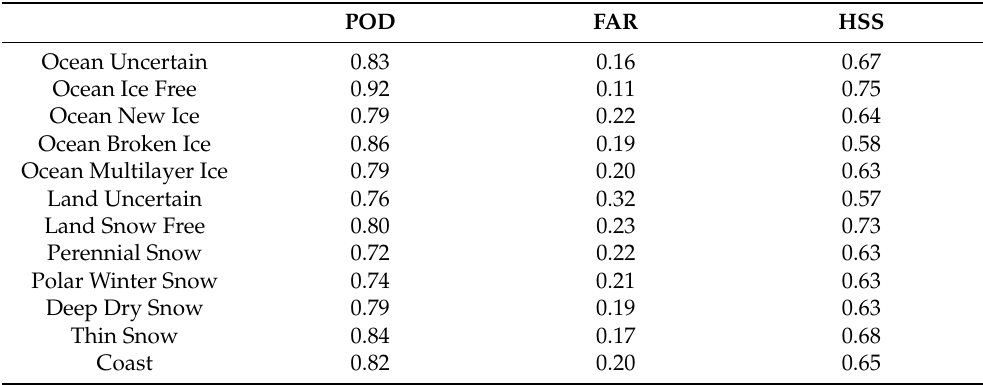
Figure 10. FSE% of snowfall rate as function of PESCA surface classification. ( a ) shows the full range of CPR snowfall rates, ( b ) highlights the FSE% obtained for the most intense snowfall rates values. Table 8. Snowfall detection statistics for PESCA surface